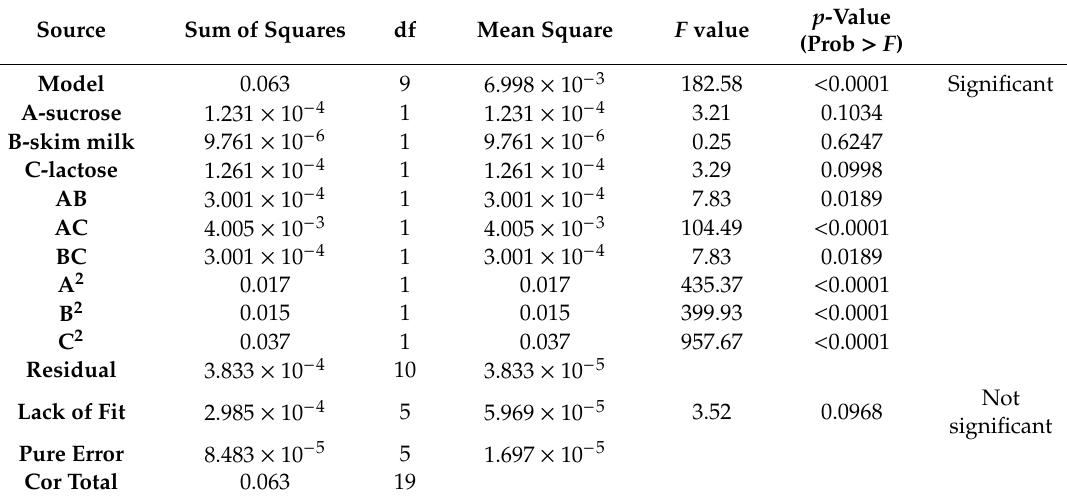
Table 3. Analysis of variance (ANOVA) and model coe ffi